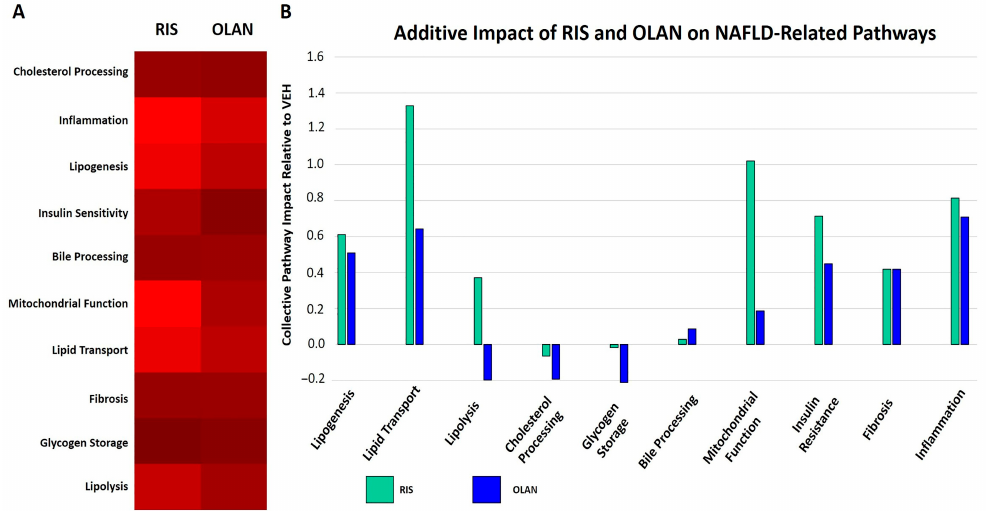
Figure 3. Dysregulation of pathways leading to NAFLD during risperidone and olanzapine treatment. DE proteins measured in this study are integral parts of several pathways in the KEGG database known to contribute to NAFLD. The number of proteins altered in RIS- or OLAN-treated mice (relative to VEH-treated controls) in each pathway group were tabulated ( A ). The intensity of red ( λ = 100–255 nm) reflects the number of proteins per pathway significantly di ff erent from VEH-treated mice during RIS treatment (left panel) and OLAN treatment (right panel). The aggregate changes in functionality of pathways across proteins compared to VEH-treated mice for RIS and OLAN are depicted ( B ). RIS and OLAN dysregulated inflammation, fibrosis, insulin resistance, and lipogenesis at comparable levels, but vary markedly in their impact on pathways related to lipolysis, lipid transport, glycogen storage, cholesterol processing, and mitochondrial